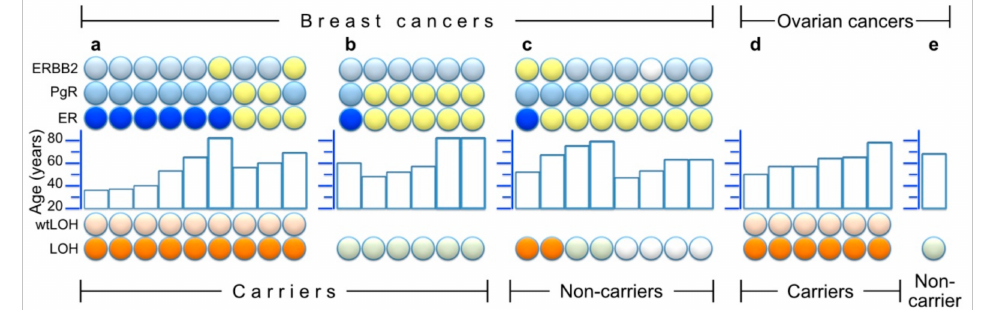
Figure 4. Summary of LOH results and / or histological staining of estrogen-, progesterone- and HER2 / Erb-B2 receptors (ER, PgR and ERBB2, respectively) in 30 tumors. Within each partition of the figure, the samples are ordered from left to right by LOH results (bottom symbols: orange for LOH and light orange above that, denoting wtLOH, light green for samples without LOH, and white for unavailable LOH information), and then by ER results (ER line of symbols: blue for ER negative, yellow for ER positive) and finally by age (middle histogram) and other receptor results (top two lines of symbols: light blue = negative, yellow = positive and white = unavailable). ( a ) Nine breast cancers from heterozygous carriers who had wtLOH in their tumors; ( b ) Six breast cancers from heterozygous carriers without LOH; ( c ) Eight breast cancers from non-carriers among close (1st and 2nd degree) relatives of genotyped or obligate carriers (four of which were available for LOH analysis of microsatellite markers); ( d ) Six ovarian cancers from carriers; ( e ) One ovarian cancer from a